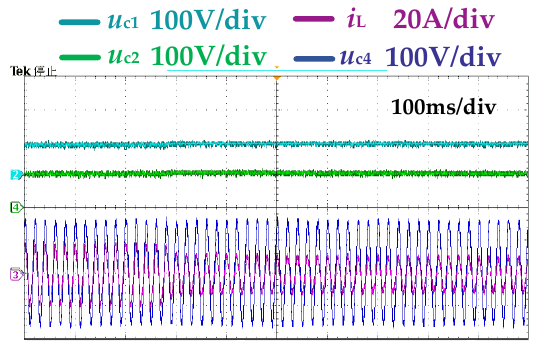
Figure 15. Experimental results of current i L and voltages u s , u c1 and u c2 with load suddenly changing from 50 Ω to 100 Ω.